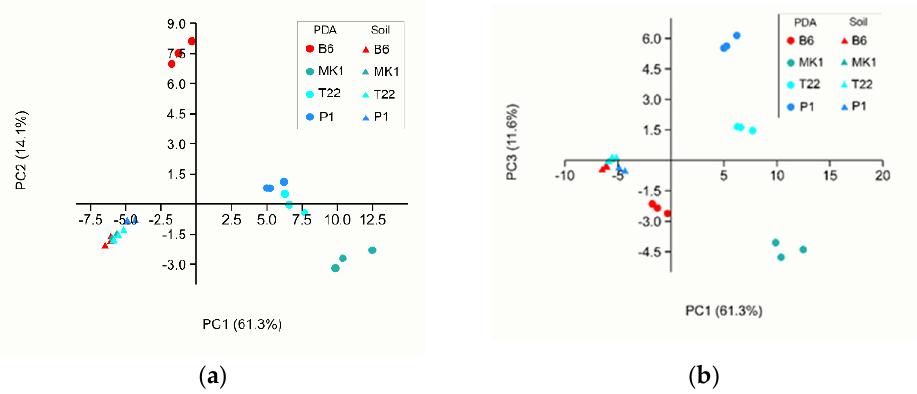
Figure 2. First three components of the PCA analysis of the PTR − Qi − TOF − MS data of VOCs emitted in the samples from PDA and soil: ( a ) PC1 and PC2 plot; ( b ) PC1 and PC3 plot. The variance explained by each component is reported in brackets.